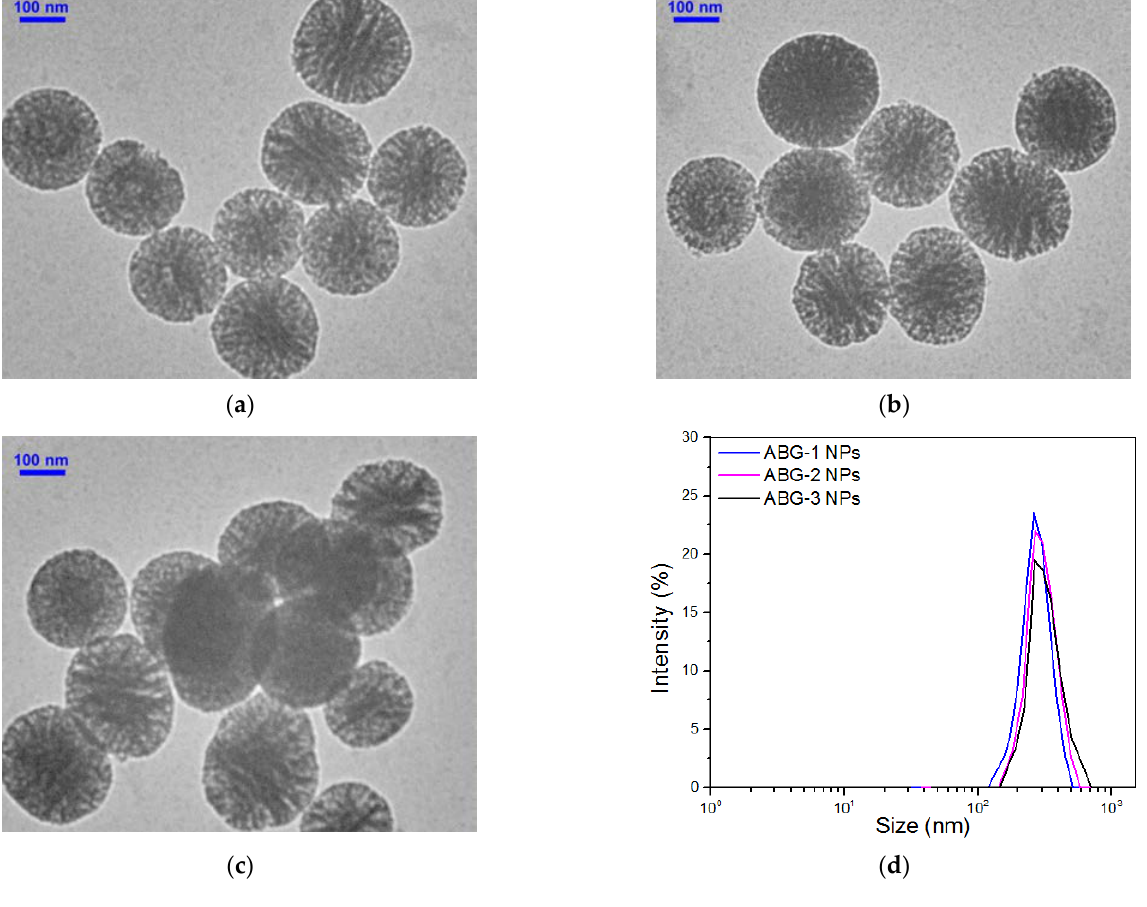
Figure 3. TEM micrographs for ABG-1 ( a ), ABG-2 ( b ) and ABG-3 ( c ) NPs as well as their size distributions ( d ).